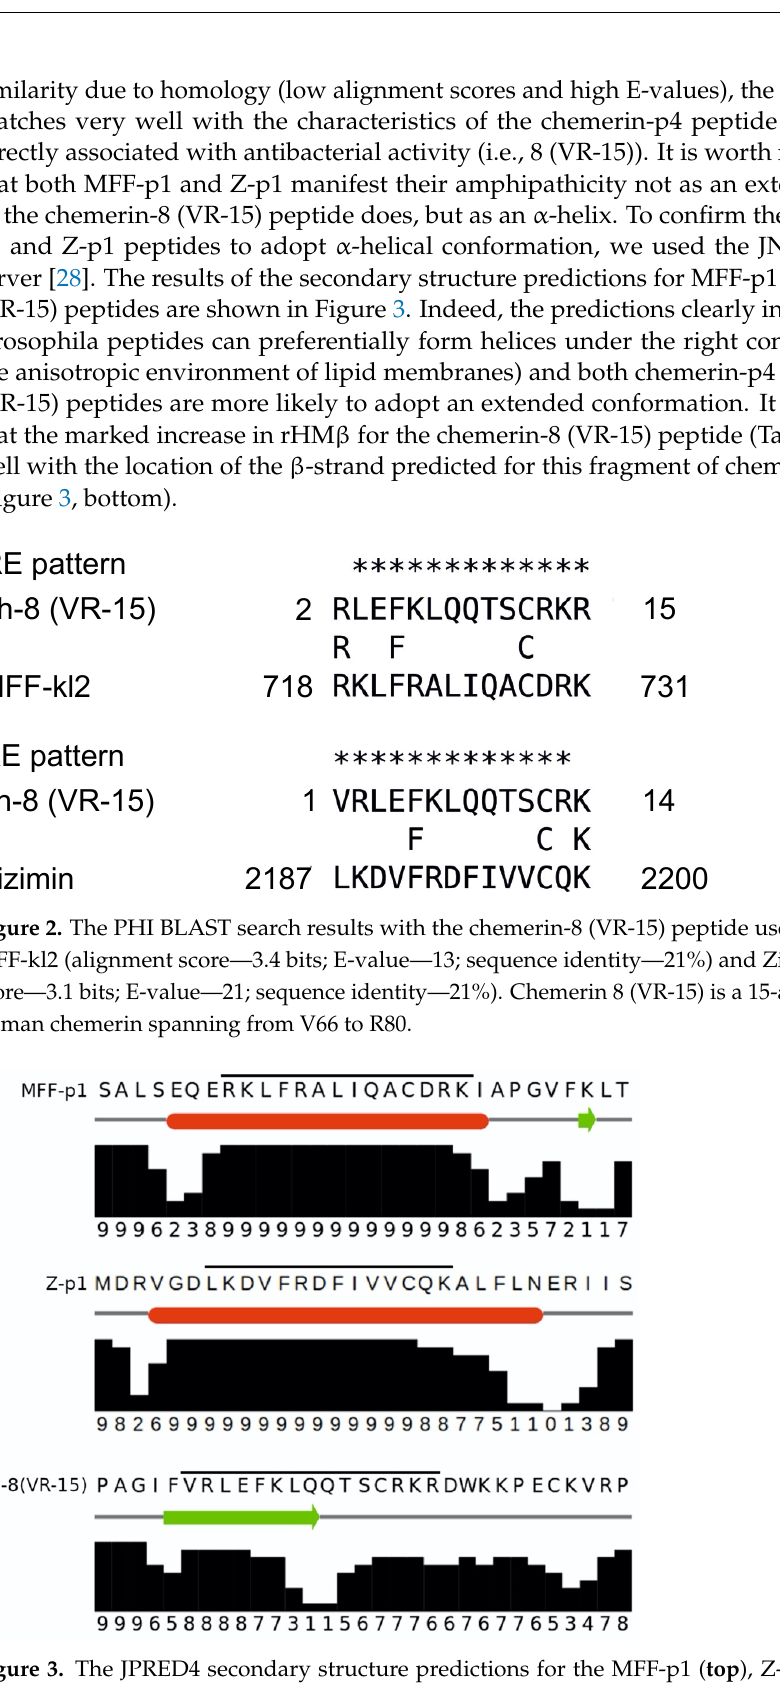
6 Figure 1. Domain architecture of MFF-kl2 ( A ) and Zizimin ( B ) of Drosophila melanogaster . PFAM domains are shown as gray boxes together with their names, PFAM accession codes, and alignment positions in protein sequences. Transmembrane helices are shown as red bars. The locations of MFF- p1 and Z-p1 are shown with the green arrow. Another hit resulted in the alignment with a Zizimin fragment (NCBI NR db id: